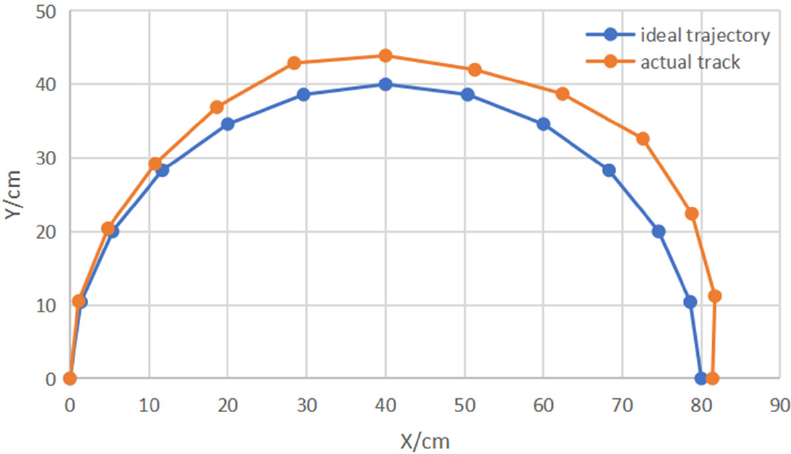
tomato picking robot chassis has a small steering deviation, can successfully enter the next ridge, and shows good steering performance between ridges.